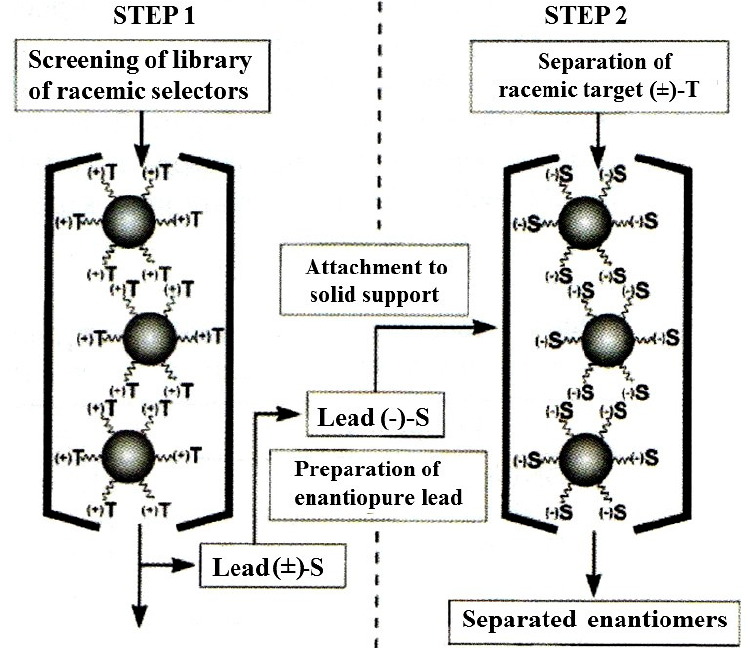
Figure 14. Reciprocal combinatorial approach to the optimization of a CSP. Reproduced with permission of the Royal Society of Chemistry from [55].